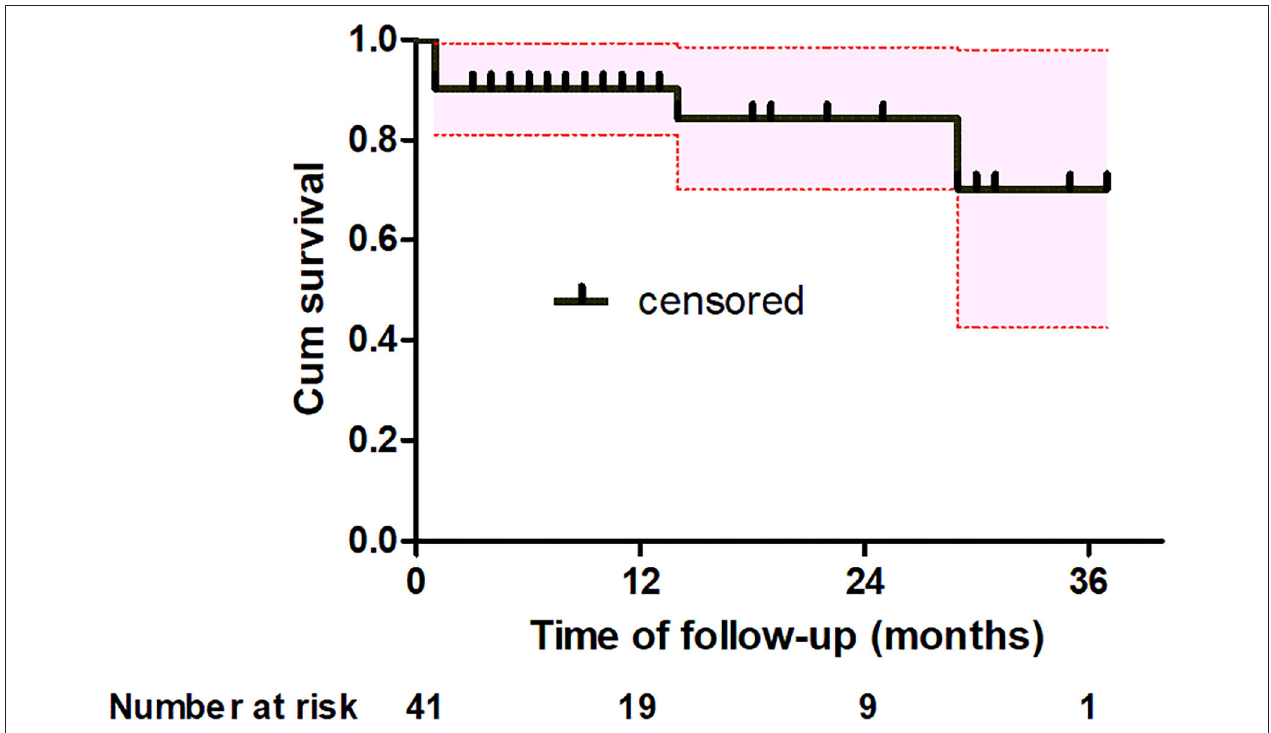
FIGURE 4 | Kaplan-Meier analysis shows estimate of the actuarial survival (black solid line) for all patients with the 95% confidence interval (red dotted